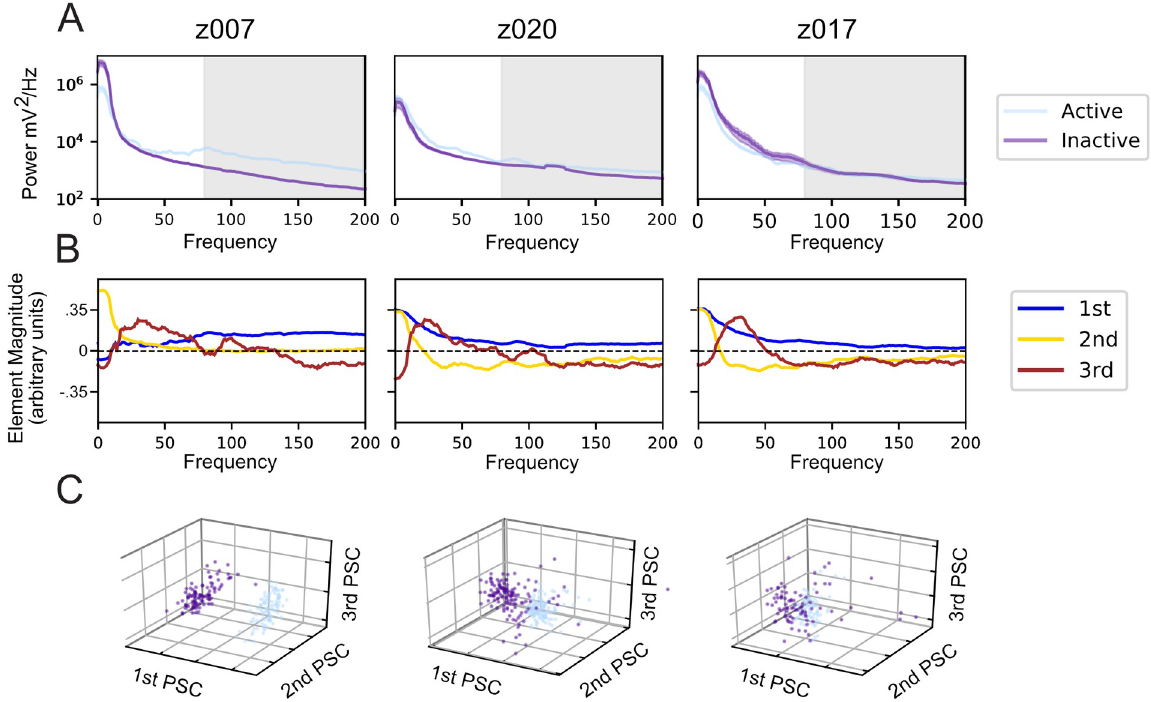
Fig 5. Na ï ve decomposition of LFP power spectra reveals song correlated features. Representative results from a single electrode channel for each of the three subjects during its highest yield day. (A) Averaged power spectra during trials centered in 1-second intervals where the bird either initiates a motif, called vocally active (light blue), or does not vocalize, called vocally inactive (purple). The 80–200 Hz, or ‘High Gamma’ band, is shaded in grey. (B) The power spectra in Fig 4 A are normalized and naively decomposed into PSCs (see Methods). The elements of the first principal spectral component (1st PSC, blue) are non-zero across all frequencies, likely due to the power law in LFP PSDs. The 2nd PSC, golden-yellow, peaks between 0 and 10 Hz. The 3rd PSC, burgundy, peaks between 10 and 30 Hz, but has variations across birds that extend into 50Hz. As the PSCs are all eigenvectors, their signs do not matter when interpreting them. This structure is largely consistent across channels and across days. (C) Projection of both the vocally active and vocally inactive trials onto the first three PSCs for the same channels in (A) and (B). The color coding is the same as (A). These projections include 84 trials per condition for z017, 100 trials per condition for z007, and 133 trials per condition for